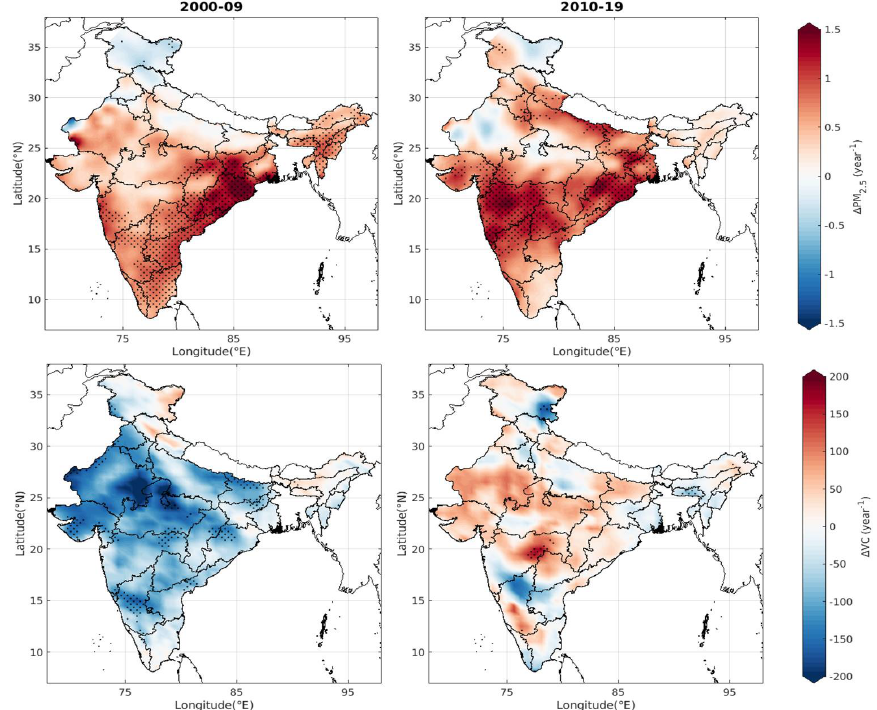
Figure 7. Spatial patterns of the annualized rate of changes in ( top panel ) PM 2.5 (in µ g / m 3 per year) and ( bottom panel ) ventilation coe ffi cient, VC (in m 2 / s per year) over India during the last decade (2000–2009) and the current decade (2010–2019). The statistically significant trends ( p < 0.05) are identified as stippled marks.